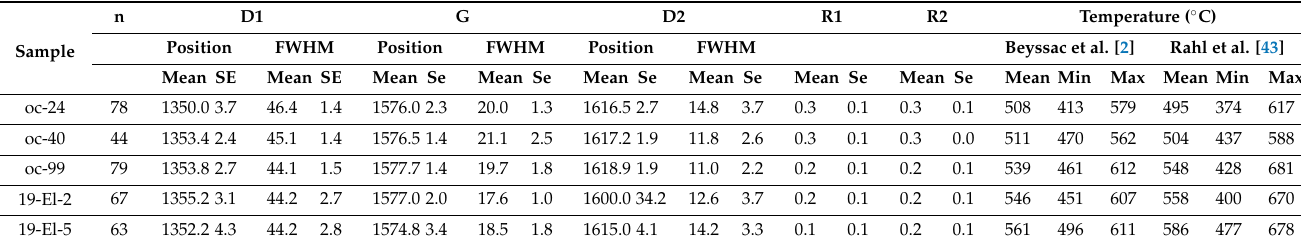
Table 5. Raman spectra position, FWHM and estimated temperature.